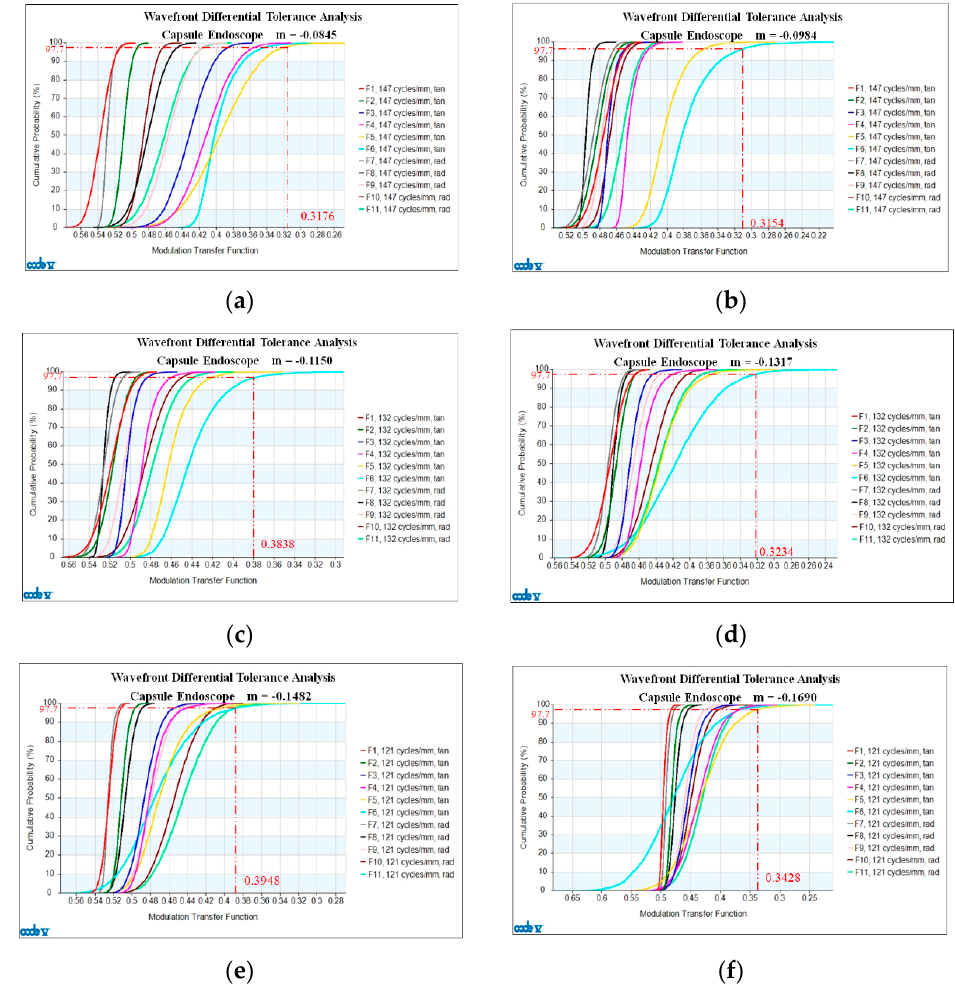
Figure 8. Cumulative probability vs. MTF: ( a ) M = − 0.0845; ( b ) M = − 0.0984; ( c ) M = − 0.1150; ( d ) M = − 0.1317; ( e ) M = − 0.1482; ( f ) M = − 0.1690. Table 5. Comparison of the design plus MTF tolerance at different magnifications. Different Zoom Positions